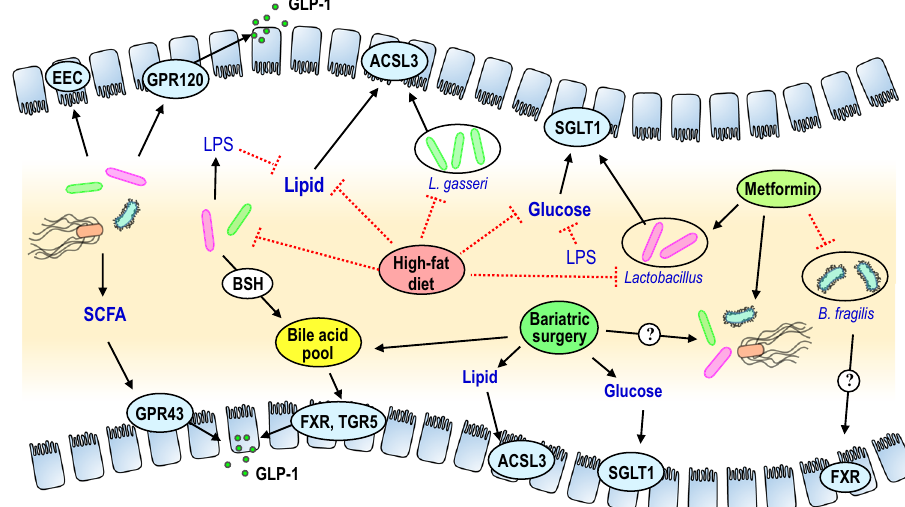
Fig. 3 Interaction of gut microbiota and small intestinal nutrient sensing. We put forward a working hypothesis for the mechanistic links between small intestinal nutrient-sensing, microbiota, peptide release, and metabolic regulation. (From Left to Right of the Schematic): Bacterial species can directly and/ or indirectly impact epithelial GPRs to alter GLP1 expression and release. Bacterial by-products such as LPS can impair lipid and glucose sensing and potentially disrupt ACSL3 and SGLT1 dependent pathways that regulate glucose and energy homeostasis. Bile salt hydrolase of bacteria contributes to the bile acid pool and regulates bile acid metabolism. As a result, changes in bile acids can alter GLP-1 release and metabolic regulation via intestinal FXR and TGR5 signaling. High-fat feeding reduces the abundance of small intestinal Lactobacillus species (e.g., L. gasseri ) and consequently inhibits ACSL3 expression and impairs lipid sensing. Lastly, metformin increases the abundance of upper small intestinal Lactobacillus and enhances SGLT1 expression and glucose sensing, while also reducing the abundance of Bacteroides fragilis that results in ileal FXR inhibition and improvement in glucose metabolism. Bariatric surgery enhances small intestinal nutrient sensing mechanisms and consequently lowers glucose levels, while changes in bile acid metabolism and FXR are necessary for the glucose-lowering effect of bariatric